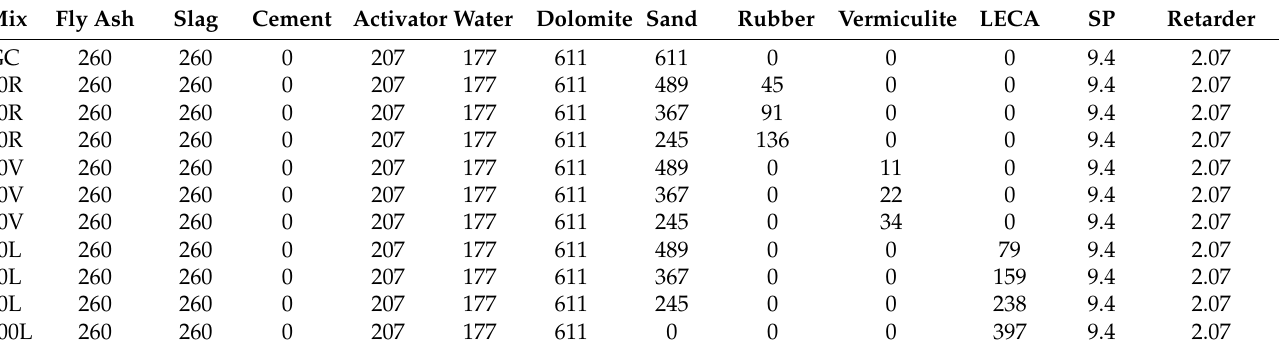
Table 2. Ingredients of concrete mixes (kg/m 3